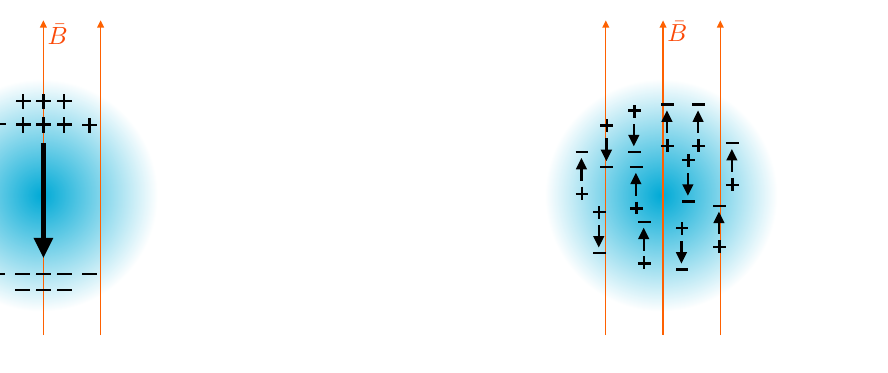
Figure 12 . A soliton of the axion field in an external magnetic field creates a coherently oscillating dipole configuration, which leads to dipole electromagnetic radiation. If instead, we replace the solition with N oscillating dipoles with random phases, we can get less power radiated than the coherent soliton case for sufficiently large N